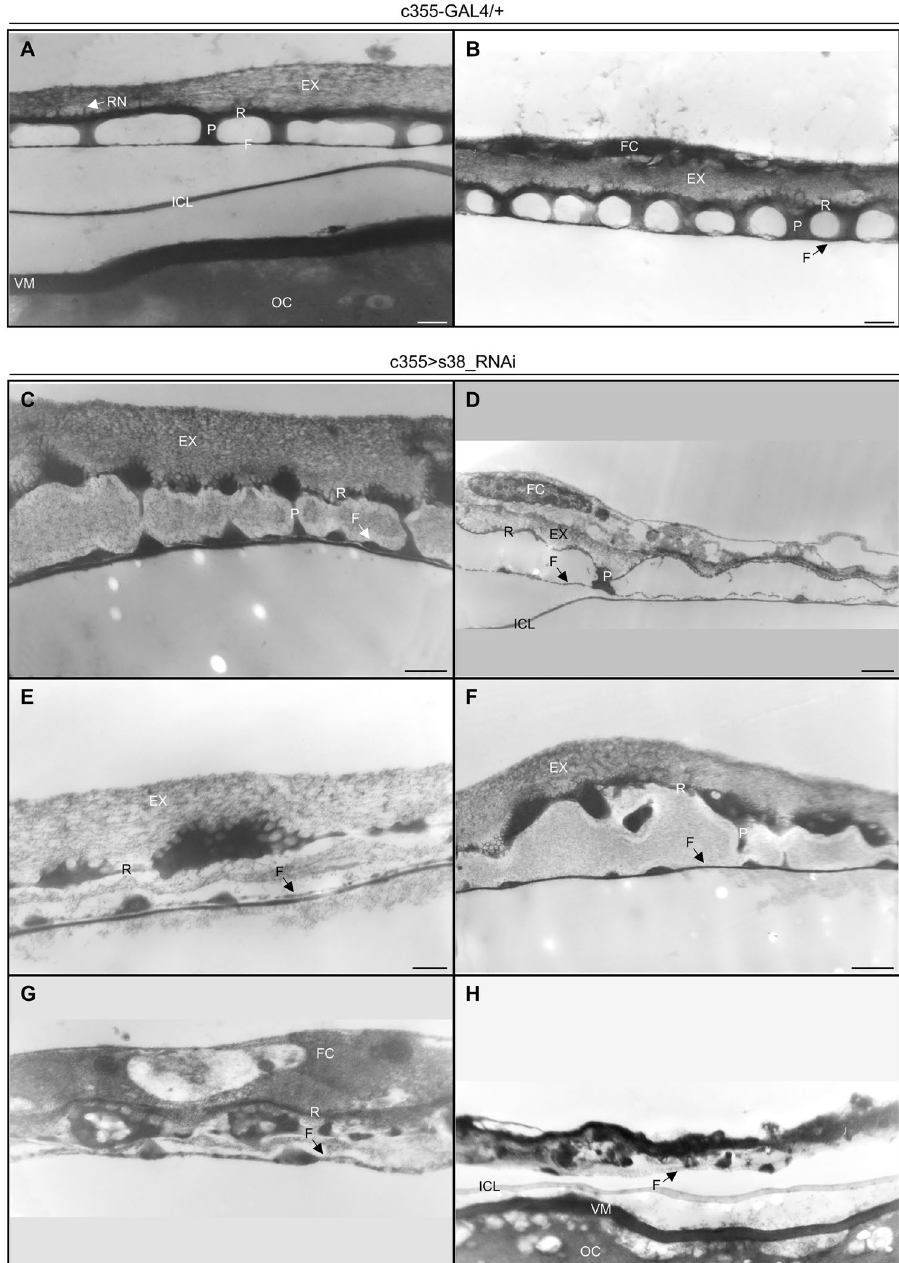
Figure 4. Lack of s38 protein causes disintegration of chorion’s radial complexity. ( A , B ) Transmission- electron-microscopy images of main-body eggshell from control (c355-GAL4/ + ) stage-14 follicles, illustrating all typical structures of the tripartite endochorion. ( C – H ) Transmission electron micrographs of eggshell’s ultrastructural organization in s38-downregulated (c355 > s38_RNAi) follicles revealing phenotypic variation of endochorion’s dysmorphia. ( C – F ) Unpredictable and stochastic endochorionic assemblies, bearing some architectural elements of a typical endochorion, albeit with thinner fragmented floor and roof structures, less prominent pillars, and larger in size cavities full of loose material (as compared to control ones). ( G ) Completely disintegrated endochorion structure, containing randomly arranged clumps of endochorionic material. ( H ) Follicle with entirely collapsed endochorion, but without detectable morphological deformities in the ICL or vitelline membrane. Number of follicles examined: control = 9, s38-downregulated = 17. OC: Oocyte, VM: Vitelline Membrane, ICL: Inner Chorionic Layer, F: Floor, P: Pillar(s), R: Roof, EX: Exochorion, RN: Roof Network and FC: Follicle Cell(s). Scale Bars: 0.5 μ